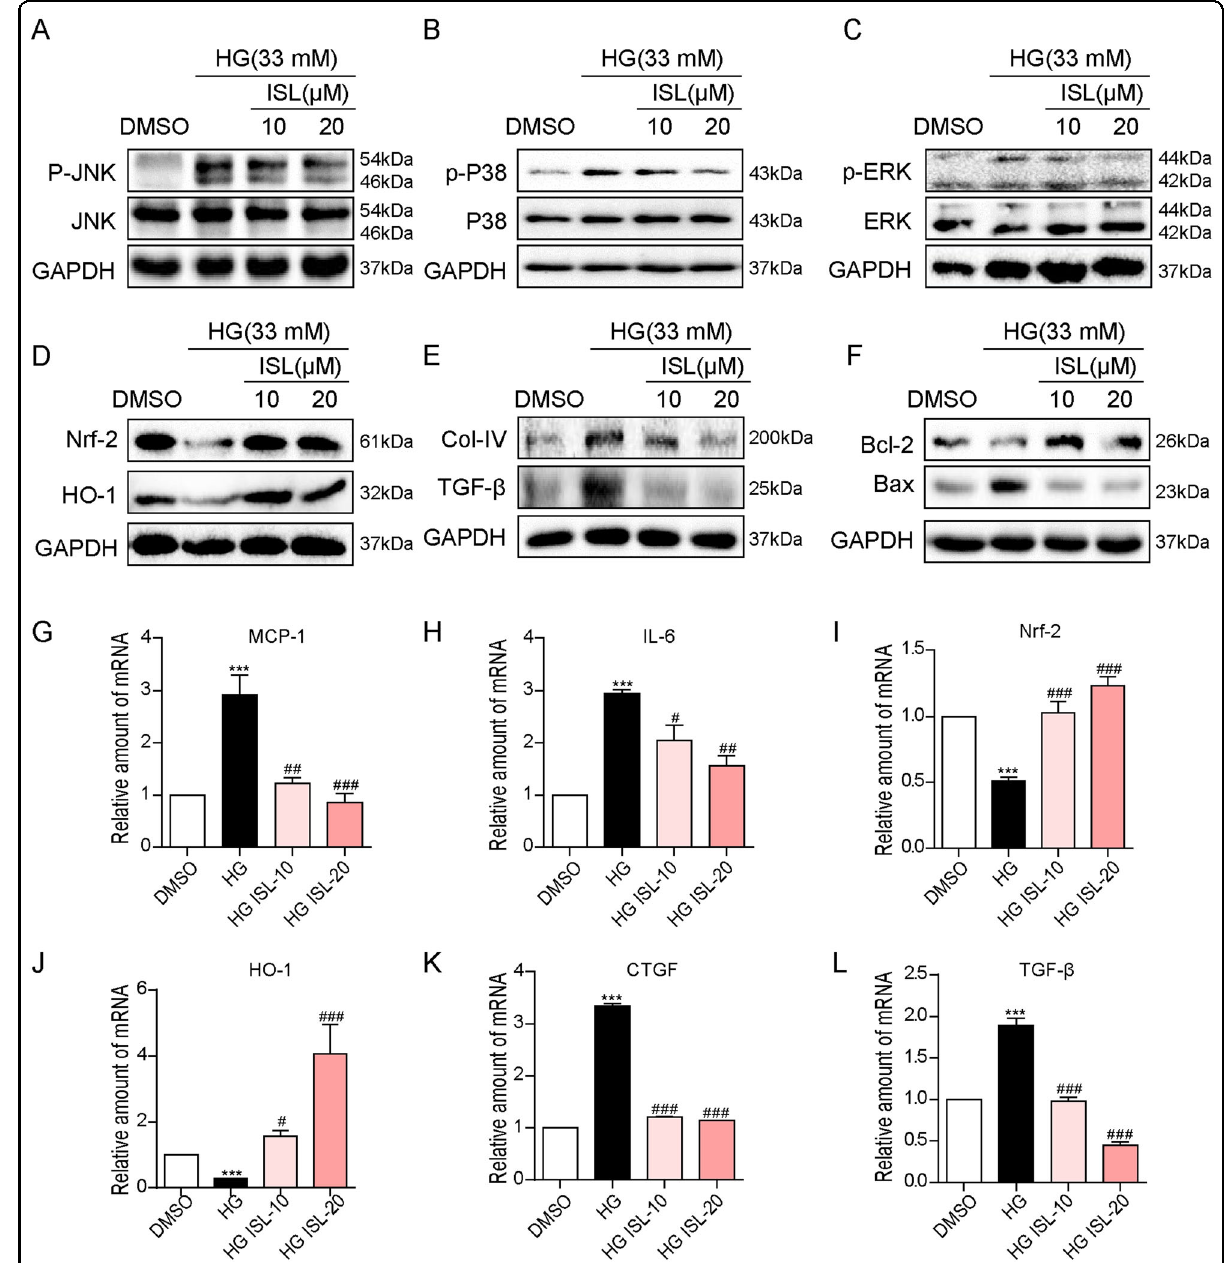
Fig. 4 ISL reduced HG-induced in fl ammation, oxidative stress, fi brosis, and apoptosis in NRK-52E cells. NRK-52E cells (1 × 10 6 ) were challenged with HG for the indicated time and subjected to 1 h pre-treatment with ISL (10 or 20 μ M). a – c After 1 h HG-stimulated, western blot analysis was performed to investigate MAPK activation, showing the phosphorylation of p38 a , ERK b , and JNK c with the corresponding total protein as a loading control. d 12 h after HG-stimulated, western blot analysis was performed to study the expression of Nrf-2 and HO-1 with GAPDH as a loading control. e , f 36 h after HG-stimulated, western blot analysis was carried out to study the expression of pro- fi brosis genes, COL-IV and TGF- β , or apoptosis-related genes, BAX and BCL-2, with GAPDH as a loading control; g – l The mRNA levels of MCP-1 and IL-6 in 6 h after HG-stimulated g , h ; or Nrf-2 and HO-1 in 4 h after HG-stimulated i, j ; or CTGF and TGF- β in 12 h after HG-stimulated k , l were detected by RT-qPCR. Bars represented means ± SEMs of four independent experiments (*** P < 0.001 vs DMSO group; # P < 0.05, ## P < 0.01, ### P < 0.001 vs HG